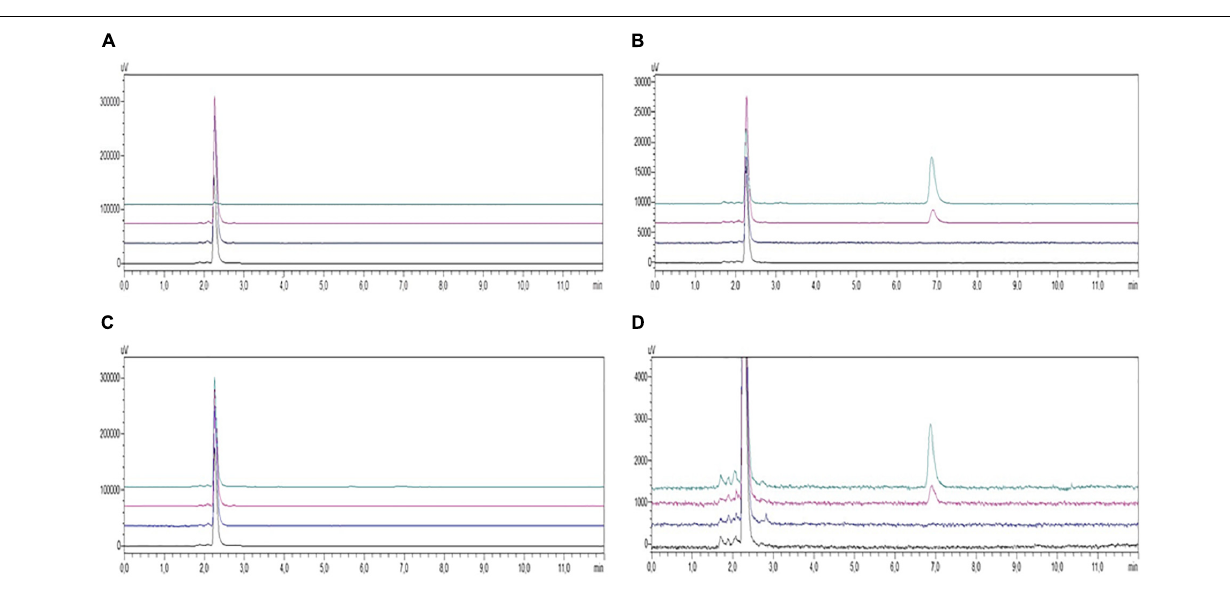
FIGURE 4 | HPLC-UV chromatograms of PBMC samples from AD patients ( A , supernatants; B , pellets) and healthy controls ( C , supernatants; D , pellets) incubated in the absence (black, untreated; blue, treated with A β ) or presence (red, treated with COMPOUND 1 and A β ; green, treated with COMPOUND 1). COMPOUND 1 10 µ M for 24 h at 37 ◦ C in cellular pellets and